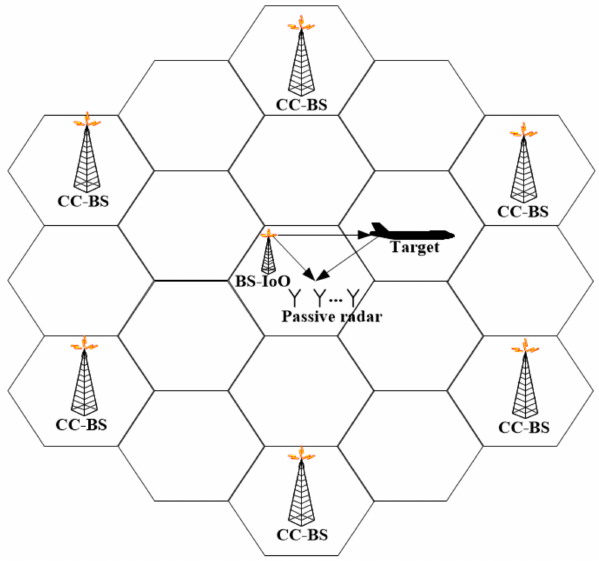
Figure 1. Schematic diagram of radar target detection structure for LTE passive